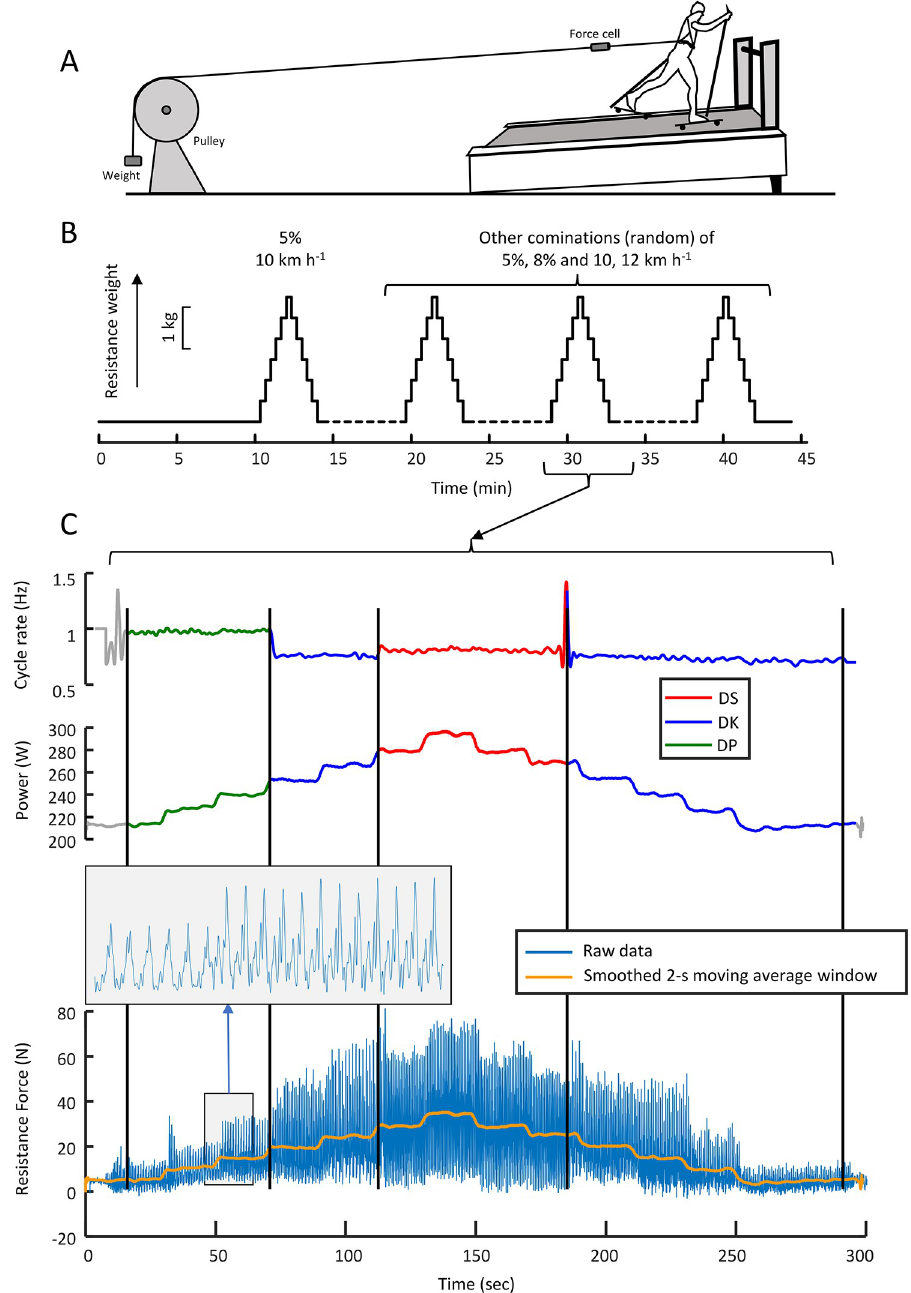
Fig 1. Equipment setup, study design, and original time traces (cycle rate, power and additional resistive force) during one session. A. Athlete on treadmill with hanging resistance weight. B. Timeline of protocol showing resistance weights. C. Cycle rate and power time trace (at v = 10 k h -1 , 8% incline). The techniques are indicated by colour. Bottom diagram shows the raw resistive force data (also in zoomed range) and smoothed over a 2 s window.